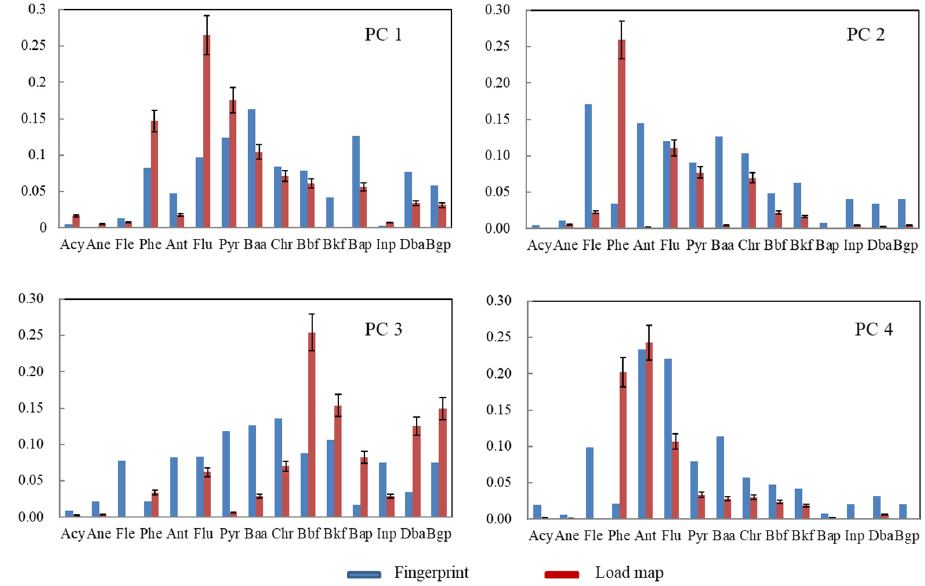
Figure 5. Source contributions derived by NMF analysis for sediment samples.